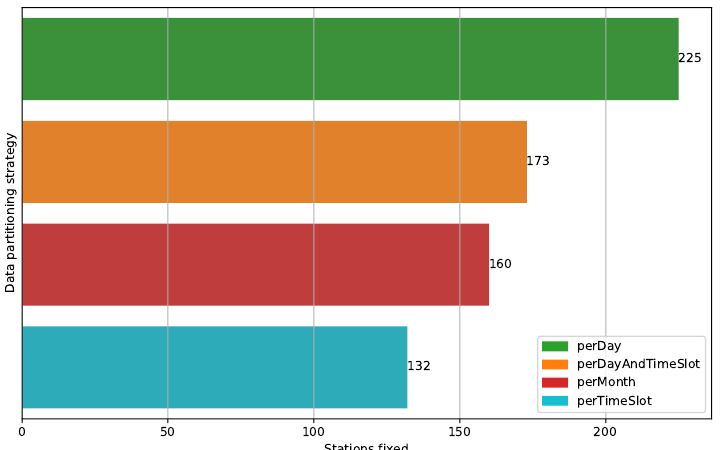
Figure 7. Reference configuration performances in terms of absolute number of station fixed on different data partitioning approaches.